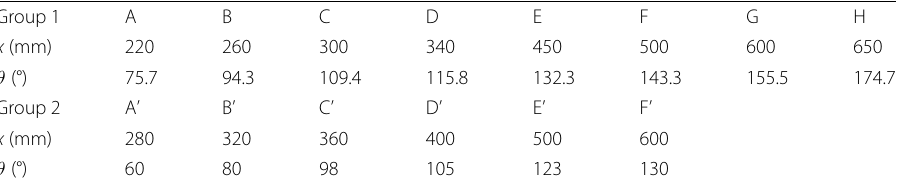
Table 1 The coordinates of probe points in the Group 1 (upstream of the transition front) and Group 2 (downstream of the transition front) Group